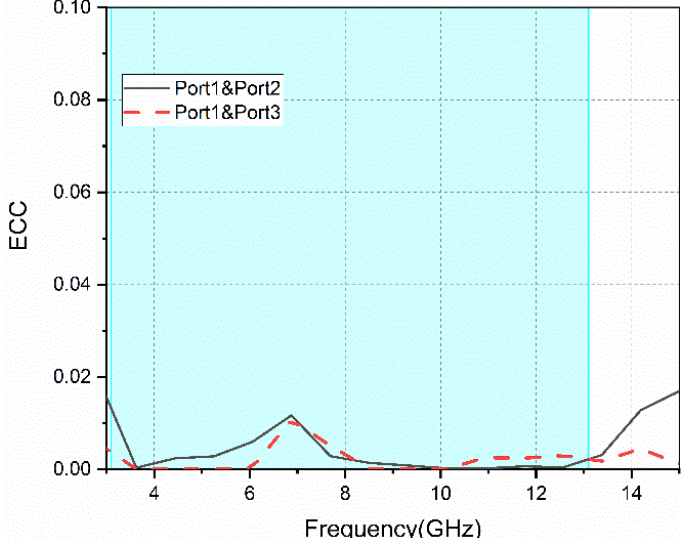
Figure 11. The ECC parameters between different ports.